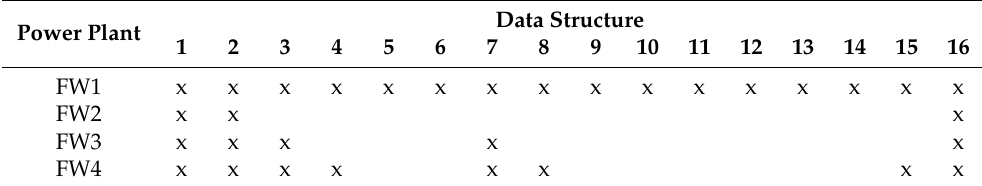
Table 5. Analyzed data structure configurations (for the tested facilities). Power